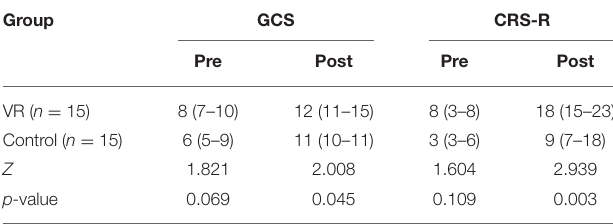
TABLE 2 | The changes of CRS-R and GCS scores in both groups before and after